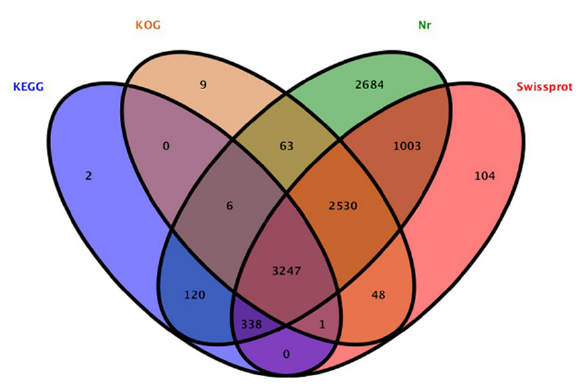
Figure 2. Annotation results of total genes in KEGG, KOG, Nr and Swissprot datasets.